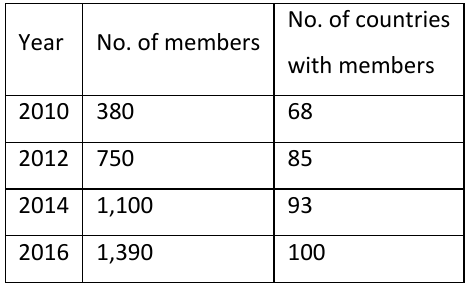
Table 1. Student Consortium membership growth.